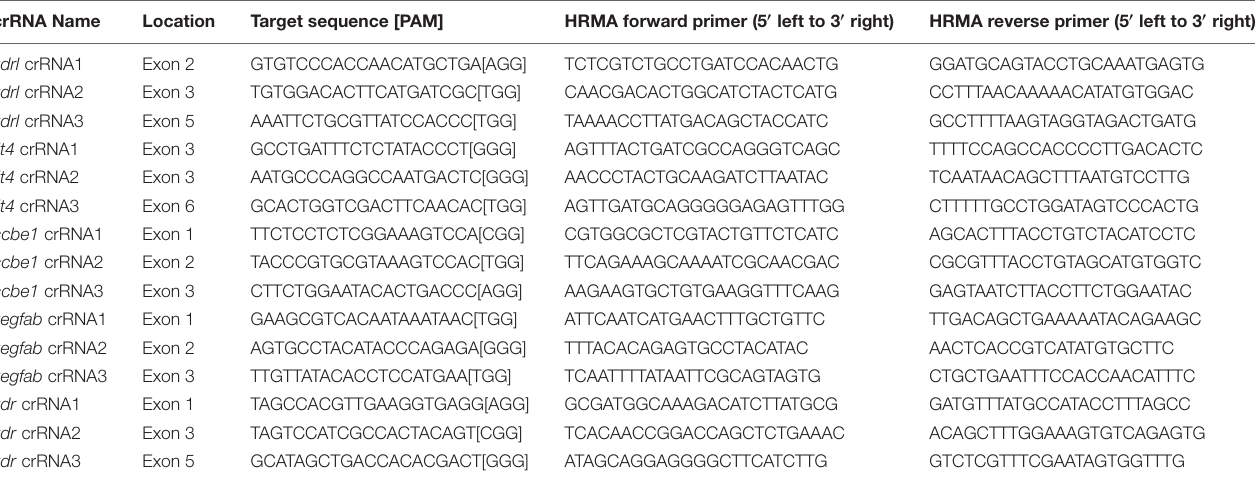
TABLE 1 | crRNA target sites, genomic locations, and HRMA primers used to analyze crRNA-injected embryos. crRNA Name Location Target sequence